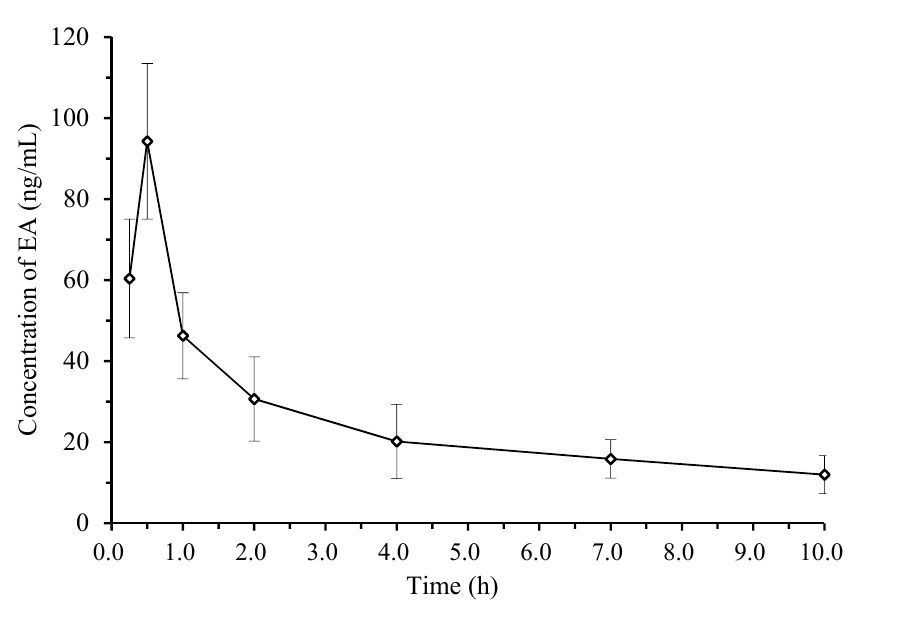
Figure 3. Mean plasma concentration–time profiles of ellagic acid in the Sprague–Dawley